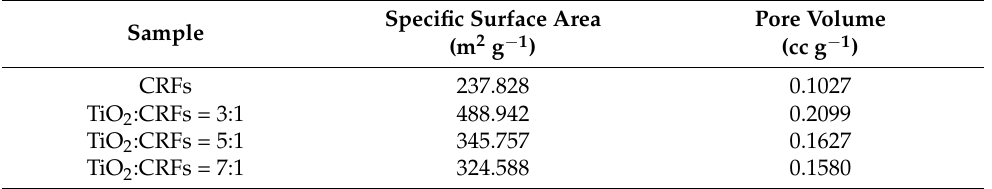
Figure 8. ( a ) Photocatalytic degradation activity of MB with different loads of TiO 2 /CRFs; ( b ) Linear transform ln(C/C0) = kt of the kinetic curves of dye degradation onto TiO 2 /CRFs under UV illuminations. ( c ) Effect of TiO 2 /CRFs Dosage on Degradation ratio of MB Solution; ( d ) Photocatalytic degradation activity of TiO 2 /CRFs with different MB concentrations. Table 1. The structural parameters of TiO 2 /CRFs and